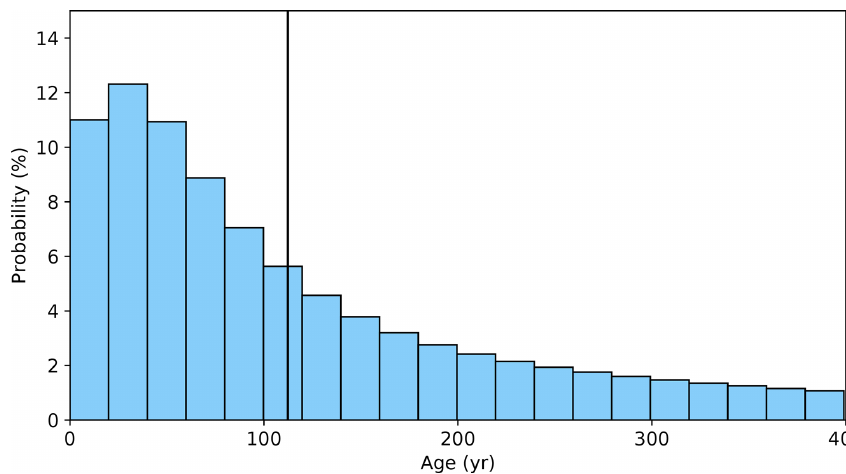
Figure 19. As in blue shading of Fig. 10 but for NADW. The black line is the expected age.